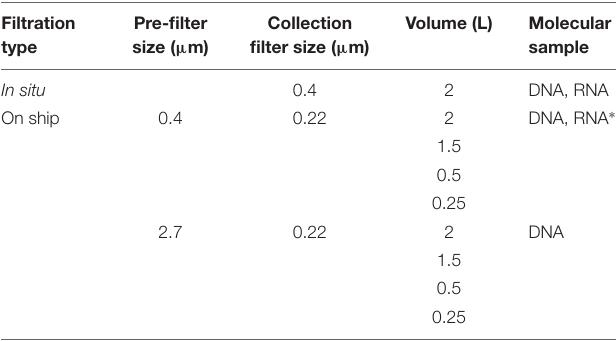
TABLE 1 | Biomass collection scheme for DNA and RNA in situ and on-ship